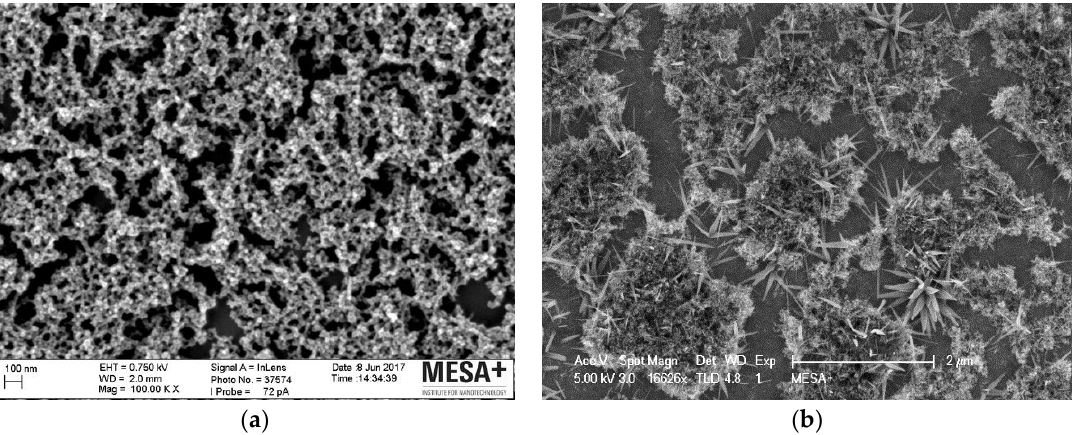
Figure 1. Scanning electron microscopy (SEM) images of the ruthenium oxide (RuOx) electrode: ( a ) Precipitated Ru(OH) 3 precursor, isolated and spread onto a silicon surface; ( b ) heat-treated precursor (at 350 °C, for 3 h) on a platinum electrode surface formed RuO 2 nanorods with a width of around 50 nm and length of 200–350 nm.